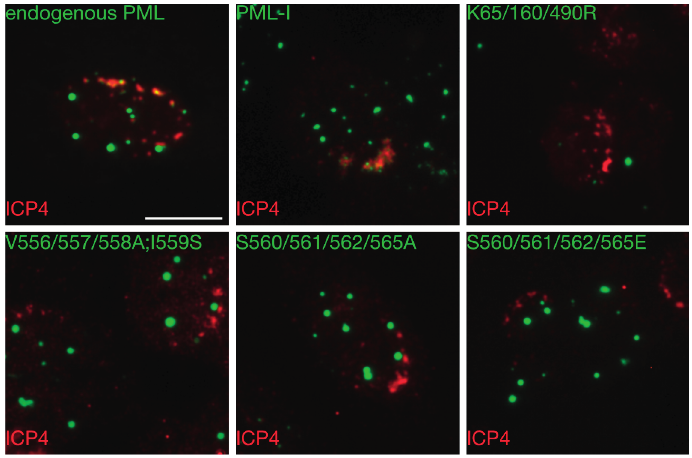
PML-I to incoming HSV-1 genomes. HA-shPML cells transduced with FLAG-, eCFP- tagged PML-I or a PML-I mutant were infected with an ICP0-null virus at 0.1 PFU/cell. At 24 hpi, the cells were fixed and stained with antibody against ICP4 as a marker of viral